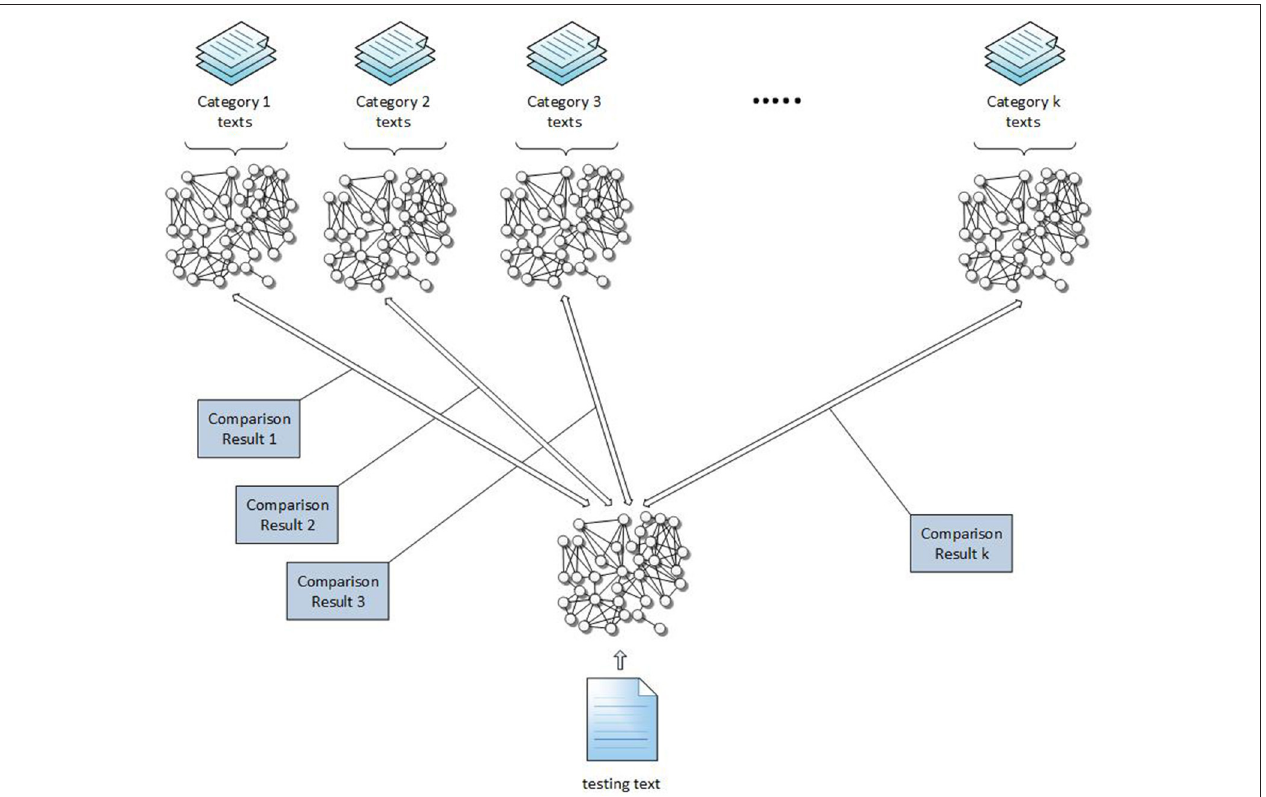
FIGURE 1 | Graph representation and comparison between testing text and